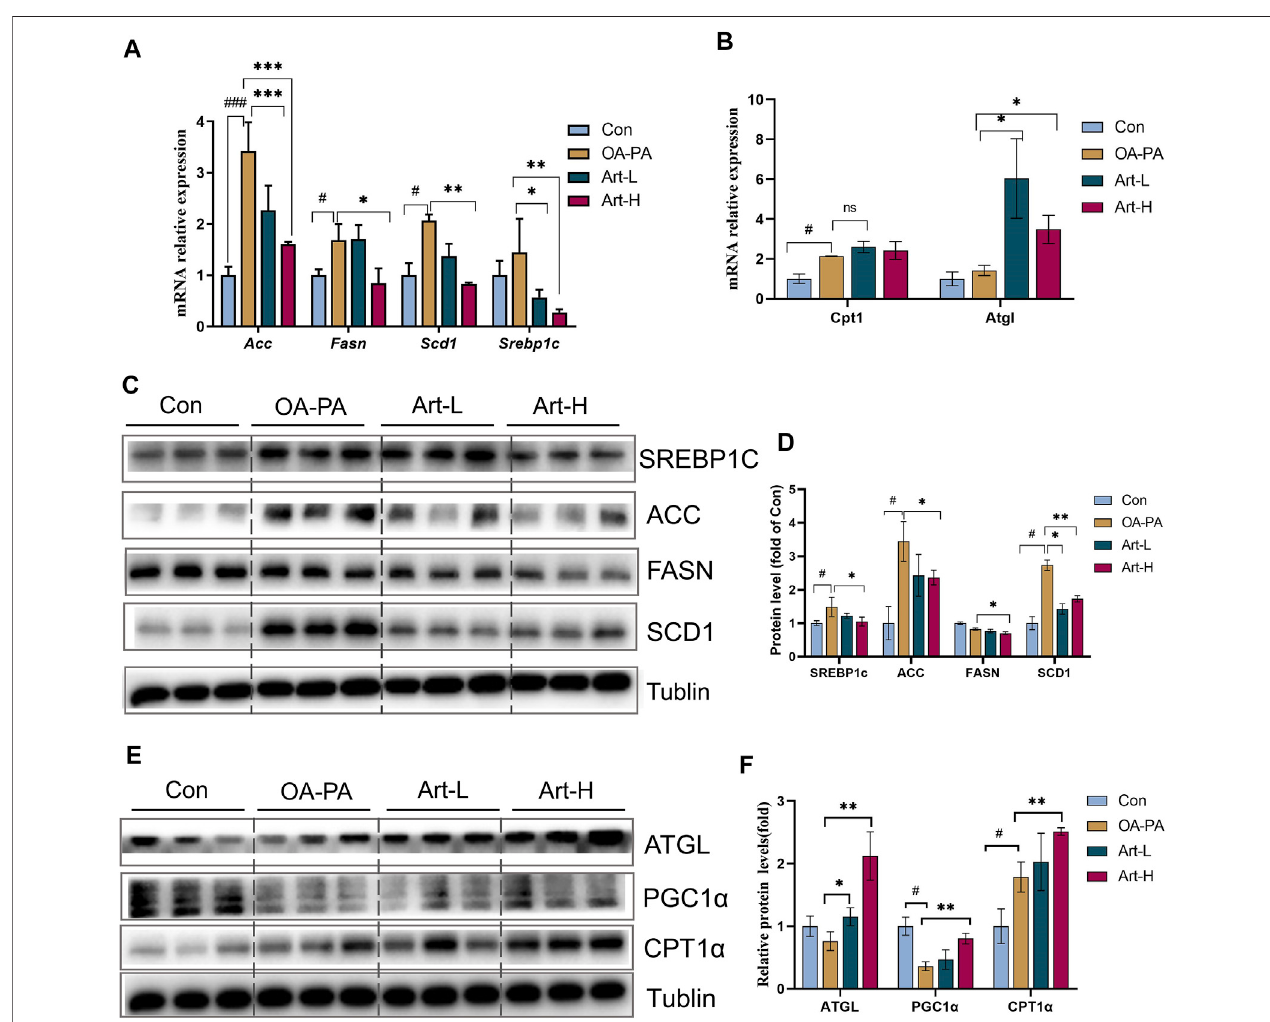
FIGURE5| ArtemetherimproveslipidmetabolisminducedbyoleicandpalmiticacidsinHepG2cells. (A,B) Real-timePCRanalysisoflipidsynthesis-relatedgenes (A) and lipolysis-related genes (B) in the HepG2 cells. (C) Western blot was used to detect the expression of lipid synthesis-related proteins in HepG2 cells. (D) Quantitative plots of the protein expression associated with lipid synthesis. (E) Western blot detected the expression of lipolytic protein in HepG2 cells ( n = 3). (F) Quantitative plots of lipid breakdown-related protein expression. Con vs. OA-PA: # p < 0.05, ## p < 0.01, and ### p < 0.001. OA-PA vs. Art-L and Art-H: * p < 0.05, ** p < 0.01, and *** p <